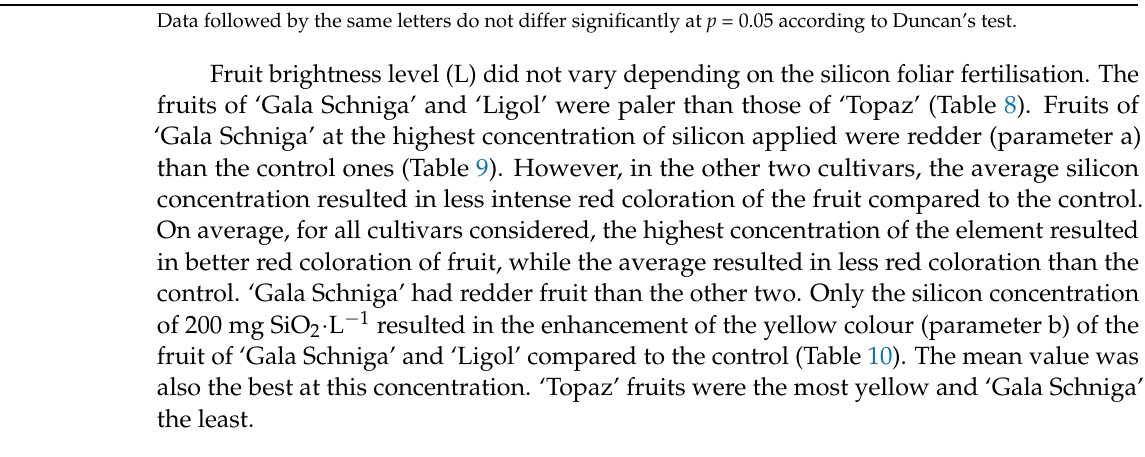
Table 8. The fruits brightness level (L) depends on cultivar and foliar silicon treatment.